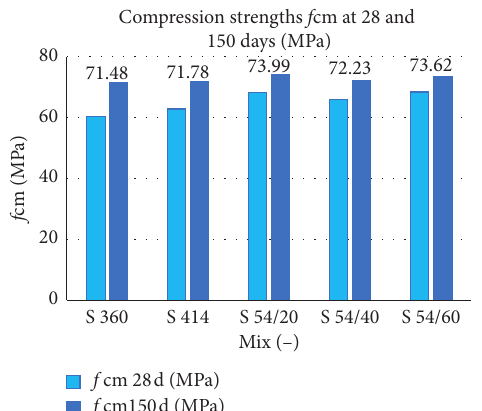
× 10 − 2 m 2 /s). 0 (%) and D (